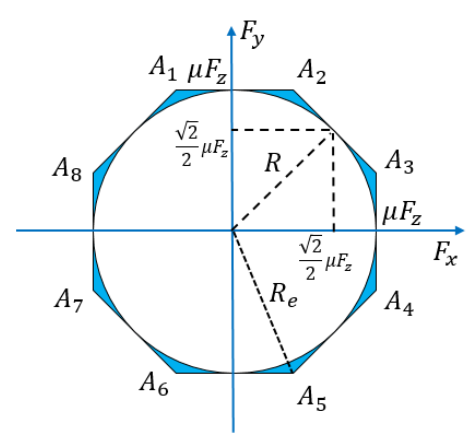
Figure 2. Tire friction